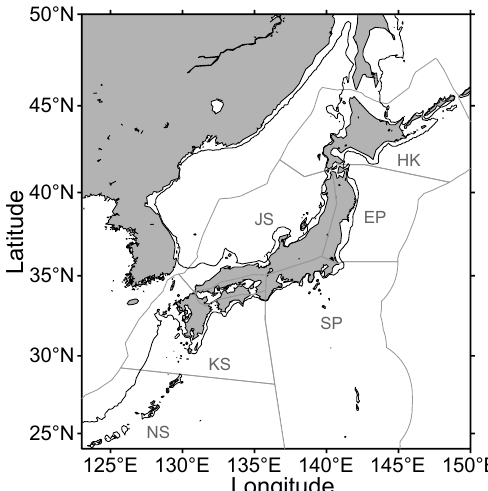
Figure 2. An area covered by GCOM-C/SGLI FAI around Japan(123 ◦ E–150 ◦ E and 23 ◦ N–50 ◦ N). The 200 m deep isobath is also depicted. The gray line divides the area into subareas, where the macroalgae area is summarized. The subarea is determined based on the subarea divisions by Fisheries Agency, Japan, to establish fishing